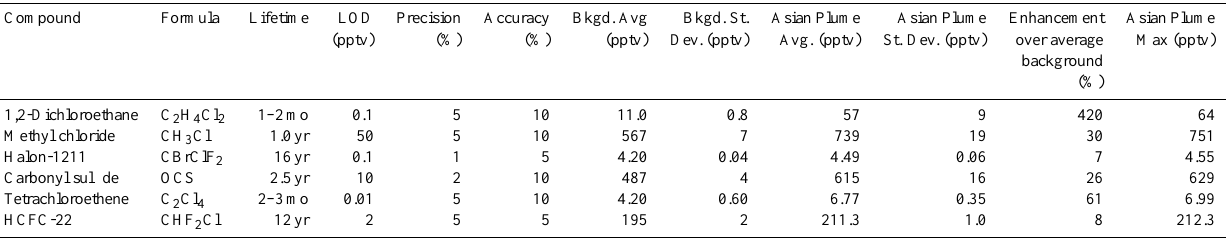
Table 2. Atmospheric lifetime, analytical details, and measurement statistics for selected compounds measured in the Asian plume. ARCTAS-A background averages also are included (see text for details).